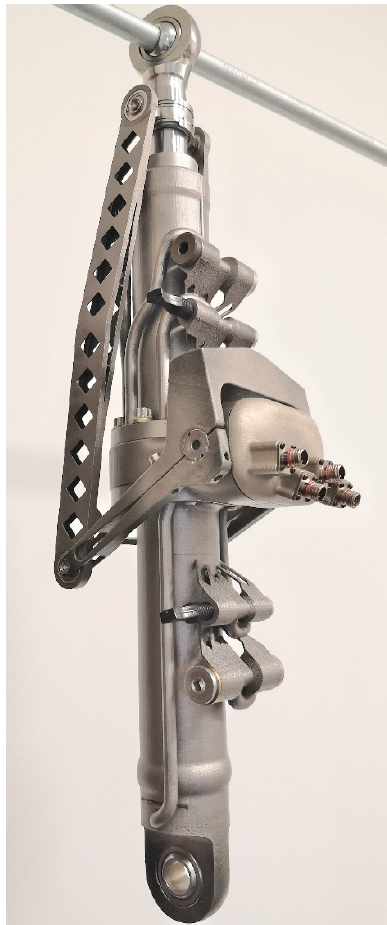
Figure 14. Assembled fly-by-wire actuator manufactured with AM